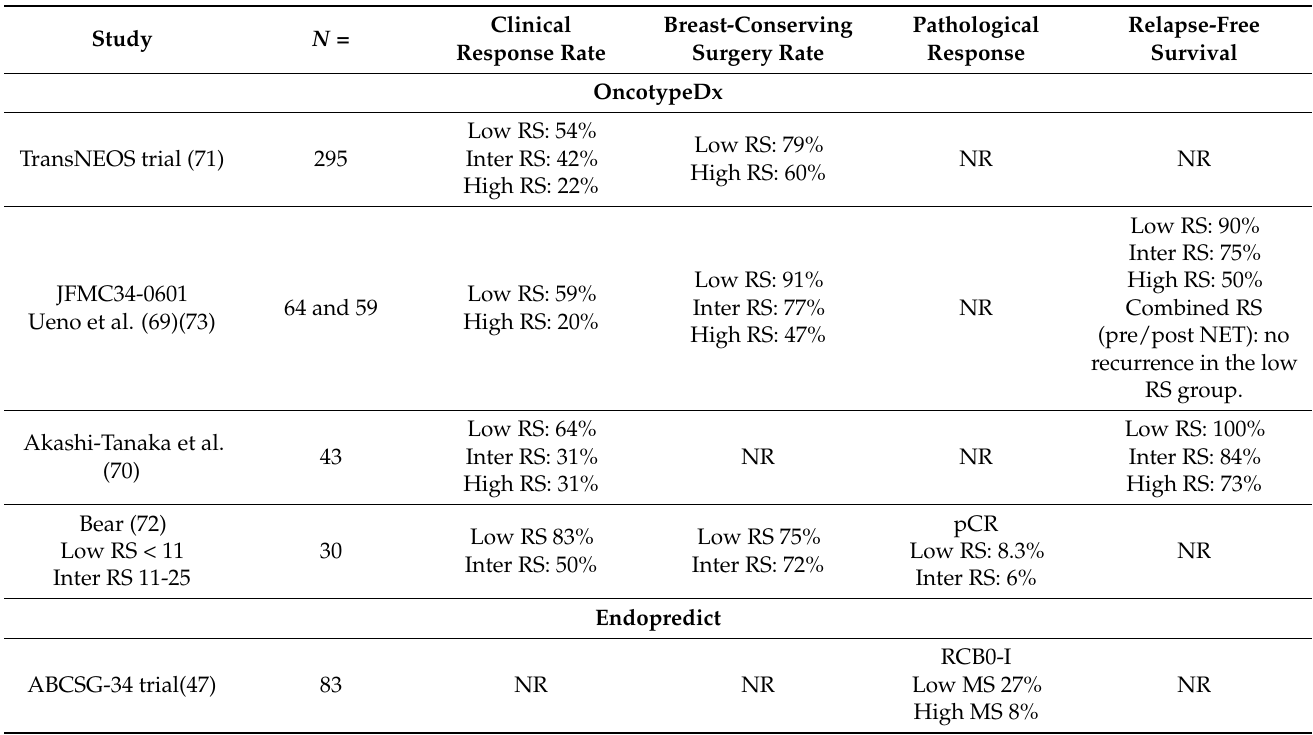
Table 5. Neoadjuvant endocrine therapy efficacy according to genomic